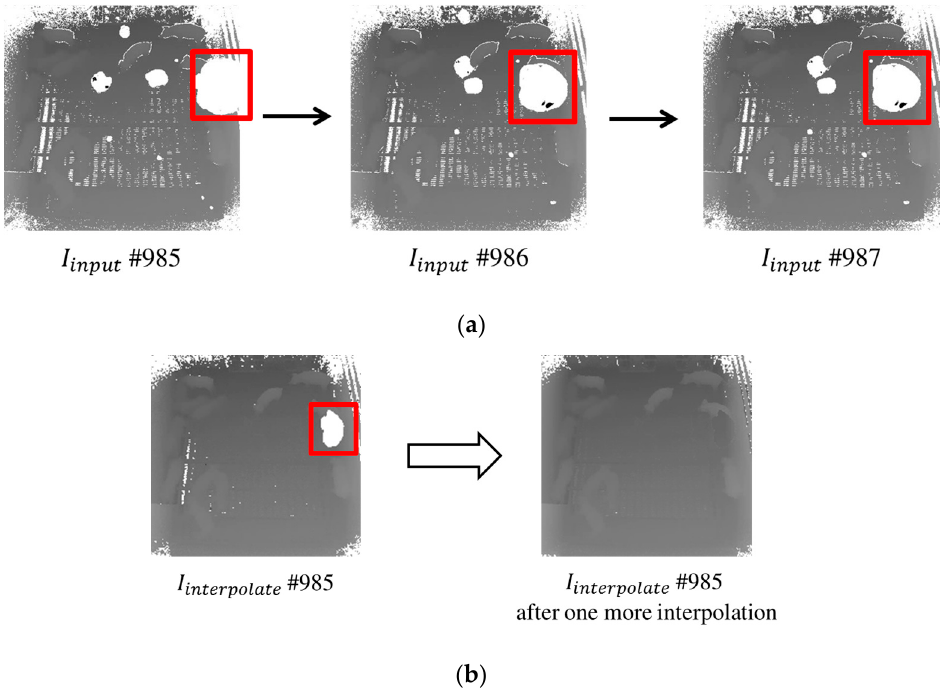
Figure 5. Problem in which noises are not removed with one interpolation and its solution: ( a ) relatively slow UDF moving in consecutive images; and ( b ) resulting image from applying the interpolation technique one more time.